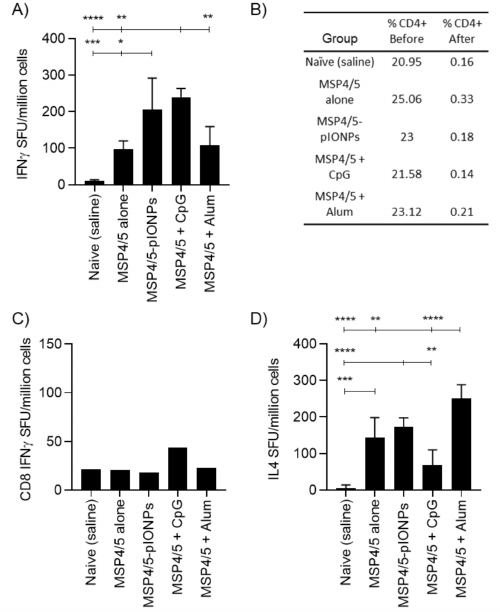
Figure 7. T cell responses to pIONPs—MSP4 / 5 compared with the TLR9 agonist, CpG 1826 and Alum. ( A ) IFN γ responses measured 2 weeks after the second injection using ELISpot against MSP4 / 5 protein (50 µ g / per mouse), immunized alone, conjugated to pIONPs (0.57% solids per mouse), mixed with CpG (25 ug per mouse) or mixed with Alum (0.3%). Each data point was measured in triplicate and averaged with individual mice presented. Mean +/ - SD shown for spot-forming units (SFU) / million cells. ( B ) Percentage of CD4 + cells before and after depletion in each group. ( C ) CD8 + -specific IFN γ responses measured using ELISpot against MSP4 / 5 protein (15 µ g / mL) with CD4 + -depleted splenocytes. ( D ) IL-4 responses measured using ELISpot against MSP4 / 5 (15 µ g / mL). Mean SFU +/ - SD presented from n = 4. All stats were completed using a one-way ANOVA with Tukey’s multiple comparison test. * p < 0.05, ** p < 0.01, *** p < 0.001, **** p <